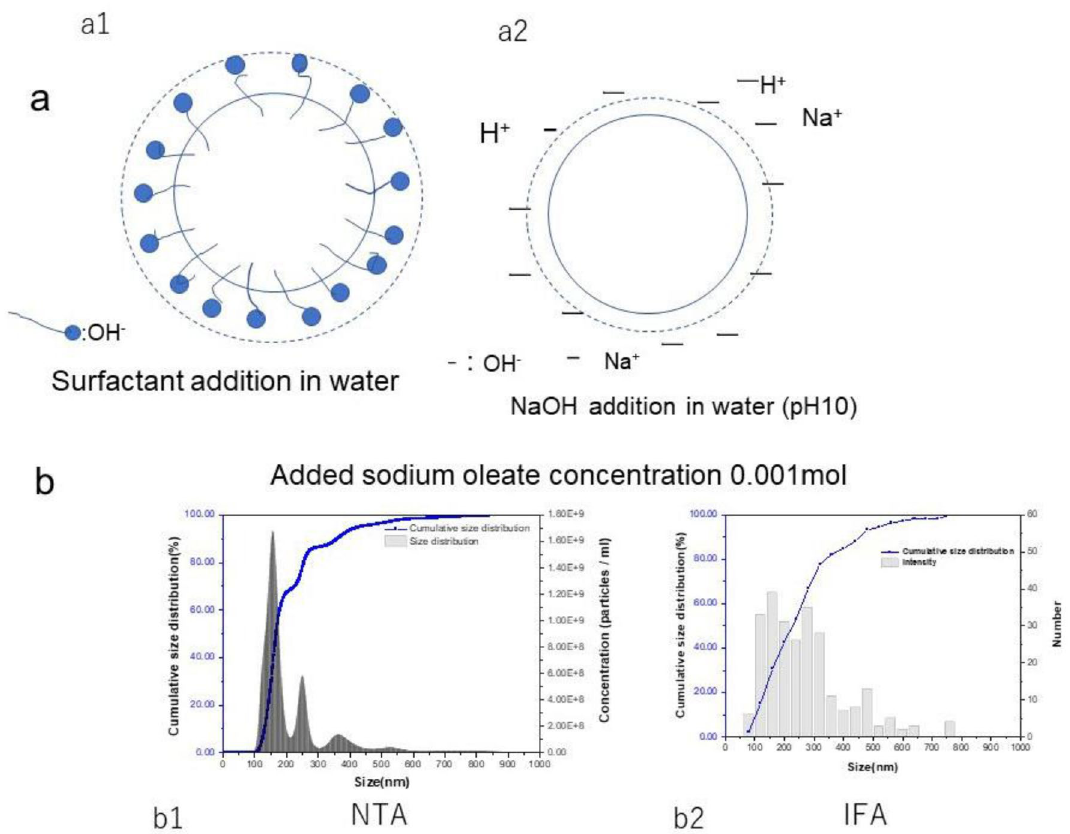
Figure 5. Size distribution of nanobubbles prepared in the presence of surfactant. ( a ) Model of surfactant adsorption onto a bubble surface in water at pH 10. ( a1 ) Oleic ion-coated nanobubble. The apparent bubble size increased for the surfactant-coated layer at pH 10. Oleic acid was dissociated to 100% oleic ion. ( a2 ) nanobubble in water at pH 10. No surfactant addition. ( b ) Size distribution by NTA and IFA. ( b1 ) D 50 is 160 nm; ( b2 ) D 50 is 181 nm. The surfactant thickness effect was assumed to be approximately 10 nm in 0.1 mmol/L sodium